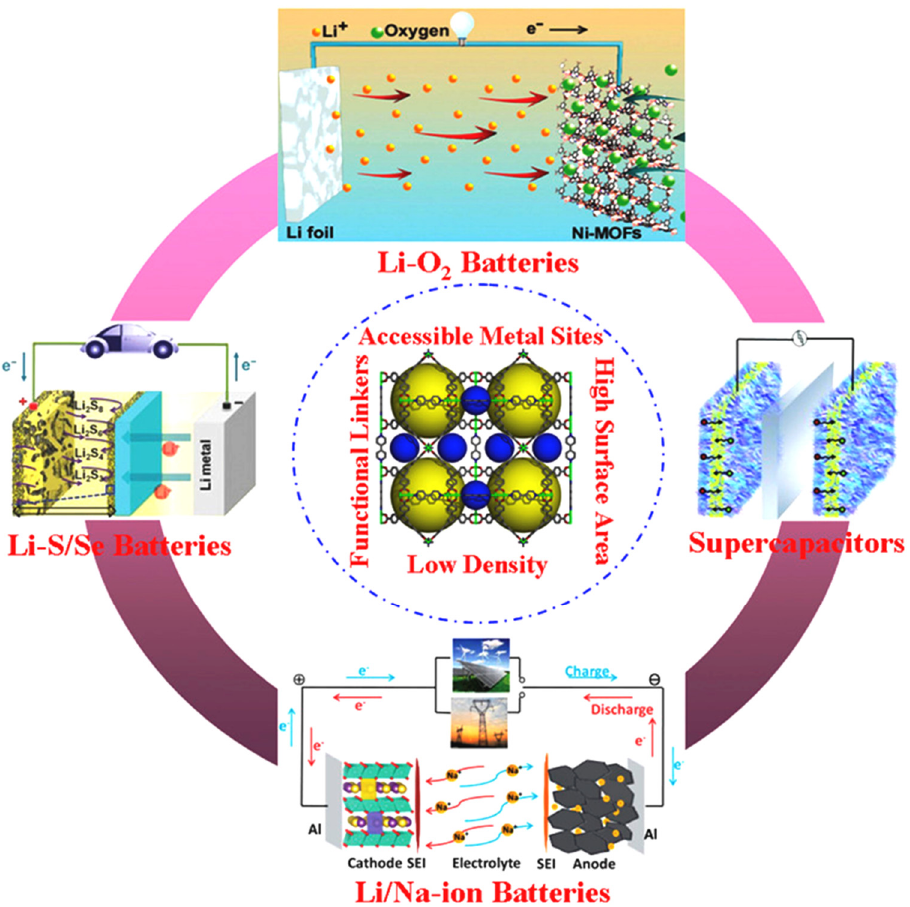
Figure 8. MOFs in energy storage and conversion devices [61]. Reproduced with permission.